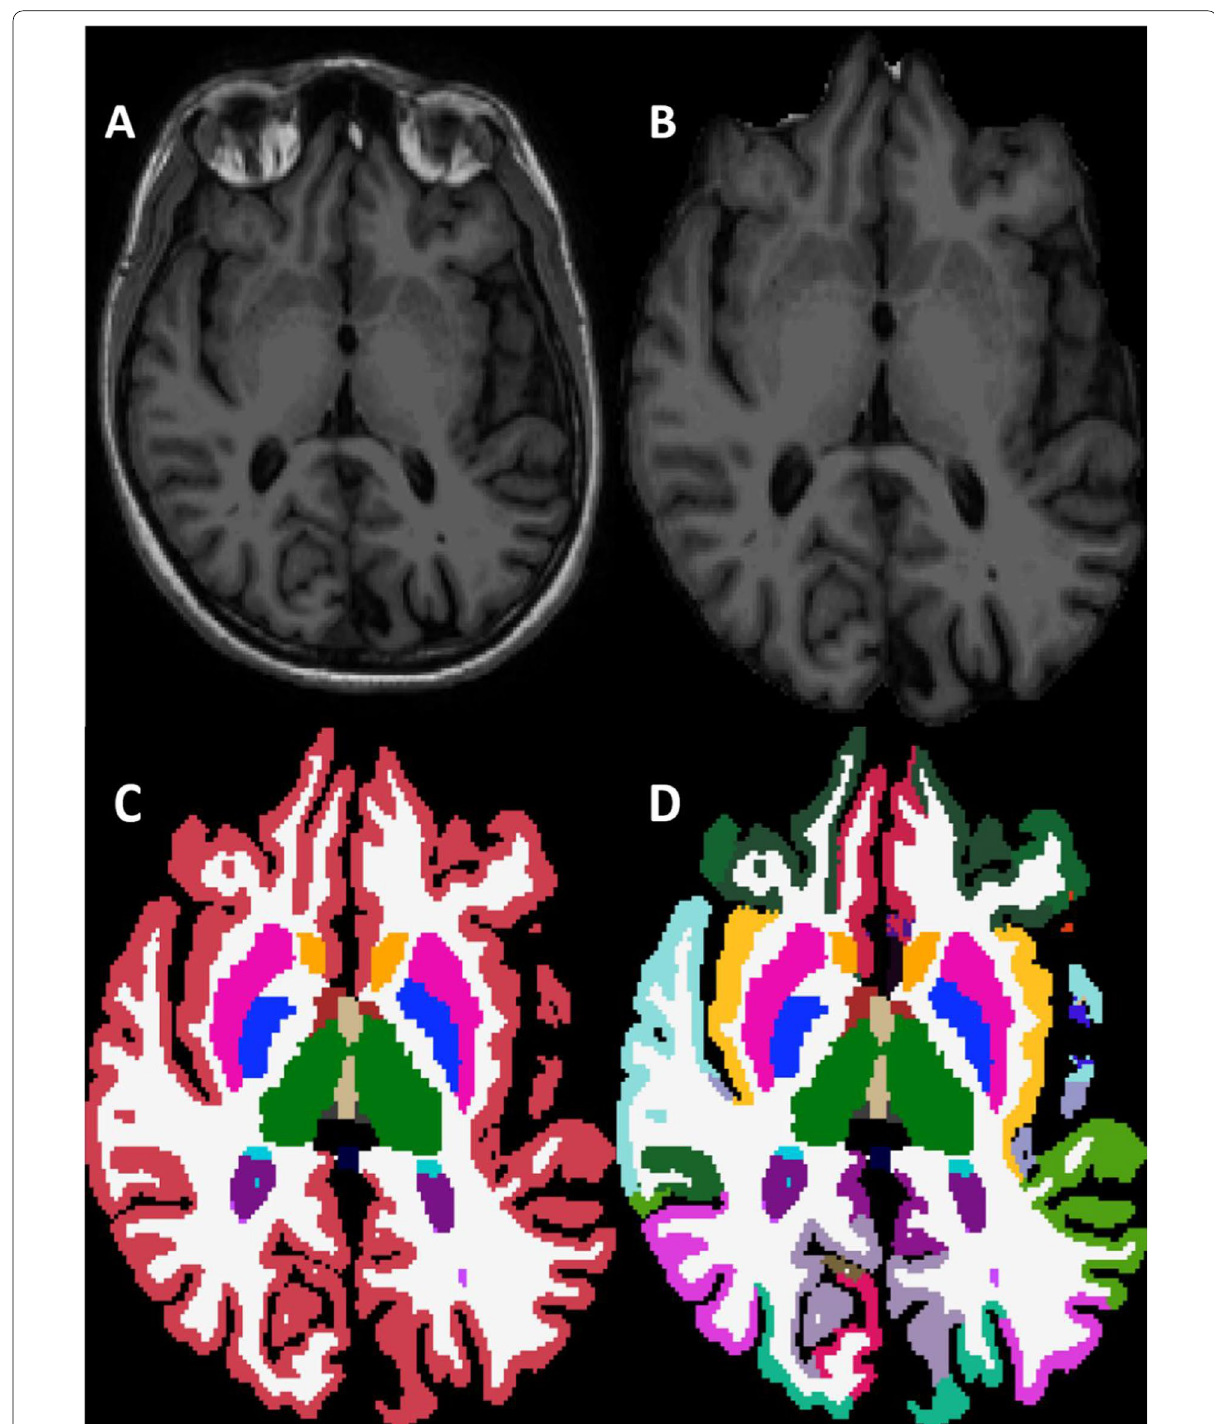
Fig. 3 A female patient aged 24 years old, known to have RRMS with EDSS score of 3. I. Cortex segmentation: raw T1WI axial plane ( A ), T1W image after brain extraction ( B ), gray and white matter segmentation ( C ) and cortex segmentation ( D ). II. Surface reconstruction: T1W image with pial surface (red line) and white matter surface (yellow line) ( E ) and surface reconstruction ( F ). III. Cortical thickness results in mm: The patient had significant decrease in the mean cortical thickness (1.848 mm, 1.944 mm), and the precentral (1.7775 mm, 1.8151 mm), postcentral (1.3831 mm, 1.4447 mm), paracentral (1.7146 mm, 1.8118 mm) and posterior cingulate cortices (1.7551 mm, 1.7117 mm) in left and right side,